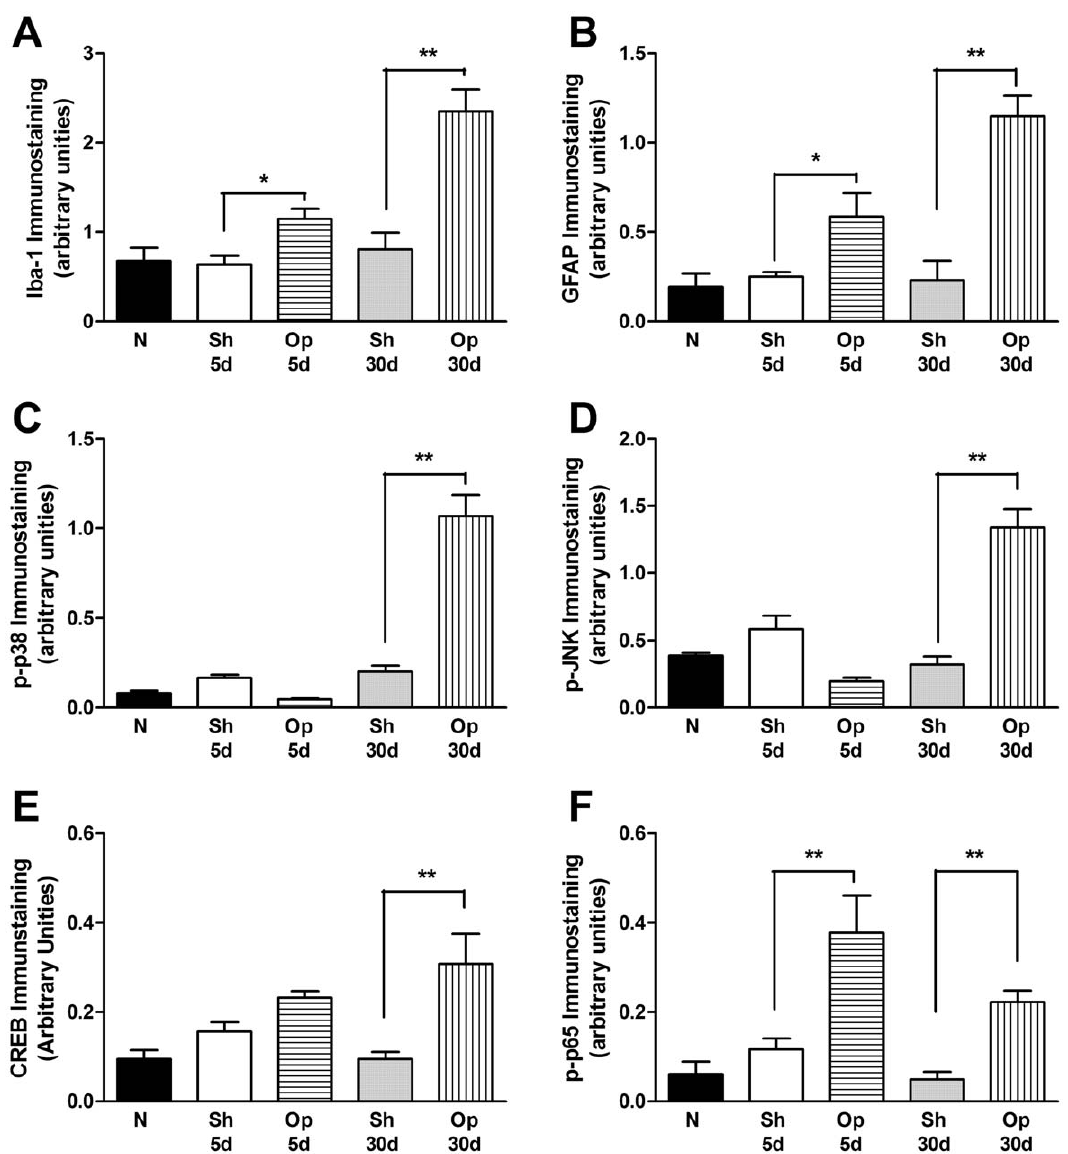
Figure 4. Brachial plexus avulsion (BPA)-induced mechanical hypersensitivity on the expression of glial cells, MAP kinases and transcription factors in the dorsal horn of the spinal cord in mice. Immunostaining of activated microglia (Iba-1, A), astrocytes (GFAP, B), phospho-p38 (p-p38, C) and phospho-JNK (p-JNK, D) MAP kinases, phospho-CREB (p-CREB, E) and phospho-p65 NF- k B (p-p65, F) transcription factors in N (naı¨ve mice), Sh 5 d (sham-operated group 5 days after BPA), Op 5 d (operated group 5 days after BPA), Sh 30 d (sham-operated group 30 days after BPA) and Op 30 d (operated group 30 days after BPA). Immunostaining intensity and area were quantified by image analysis and are expressed as arbitrary units (mean 6 SEM, n=4/slices of 4–6/groups). *p , 0.05 and **p , 0.01, compared with sham-operated of the respective group and time (one-way ANOVA followed by Bonferroni’s post hoc test). JNK: c-Jun N-terminal kinase; CREB: cAMP response element-binding protein; p65 NF- k B: nuclear phospho-p65 nuclear factor- k B (NF- k